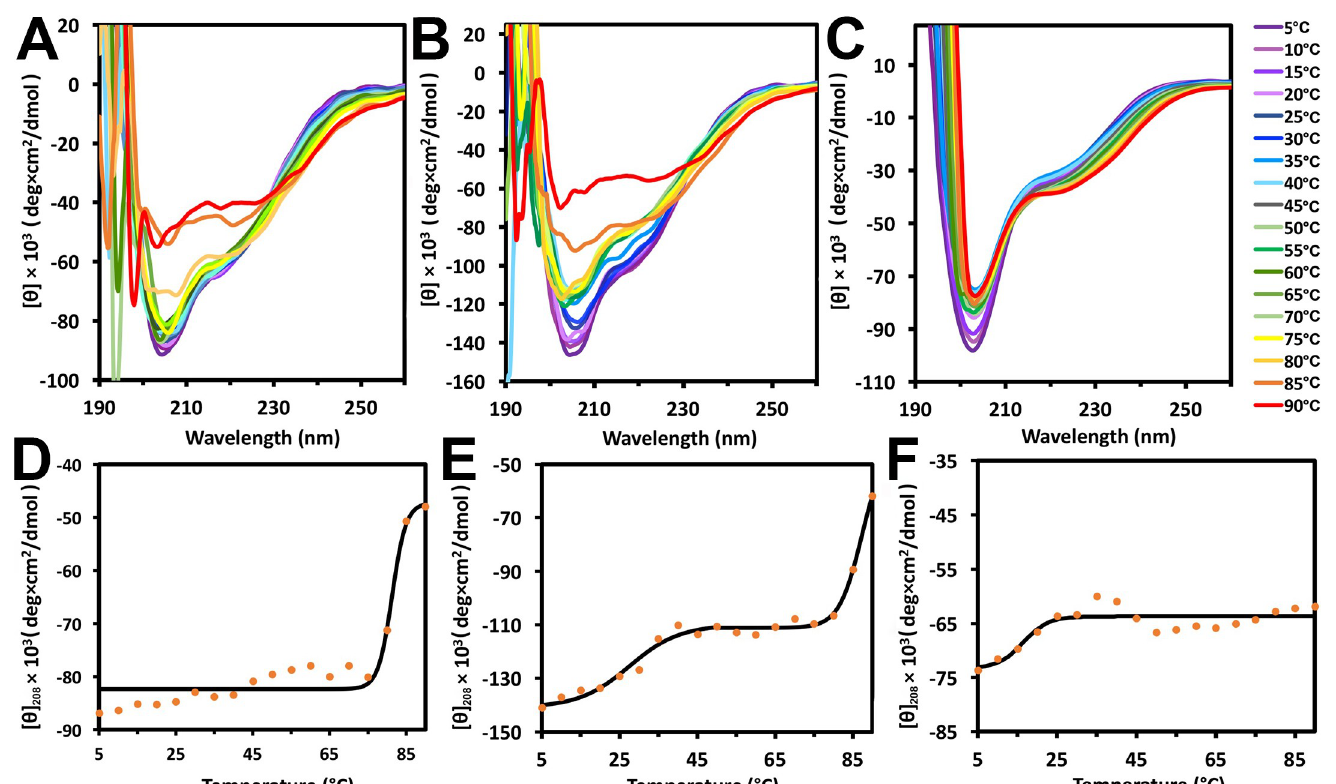
Fig 5. Far UV CD thermal unfolding profiles of hPER2c 40mer ( A and D ), 20mer ( B and E ), and dimer ( C and F ). Panel A, B, and C are the CD spectra at different temperatures ranging from 4˚C (purple) to 90˚C (red) for hPER2c 40mer, 20mer, and dimer, respectfully. The legend on the right shows the line colors and their corresponding temperatures. Panel D, E, and F are the values of mean residue ellipticity at 208nm ([ θ ] 208 ) for hPER2c 40mer, 20mer, and dimer, respectfully, plotted against temperatures in orange dots. A curve (black solid line) has been fitted to [ θ ] 208 to determine the T m of the hPER2c 40mer, 20mer, and dimer, respectfully.